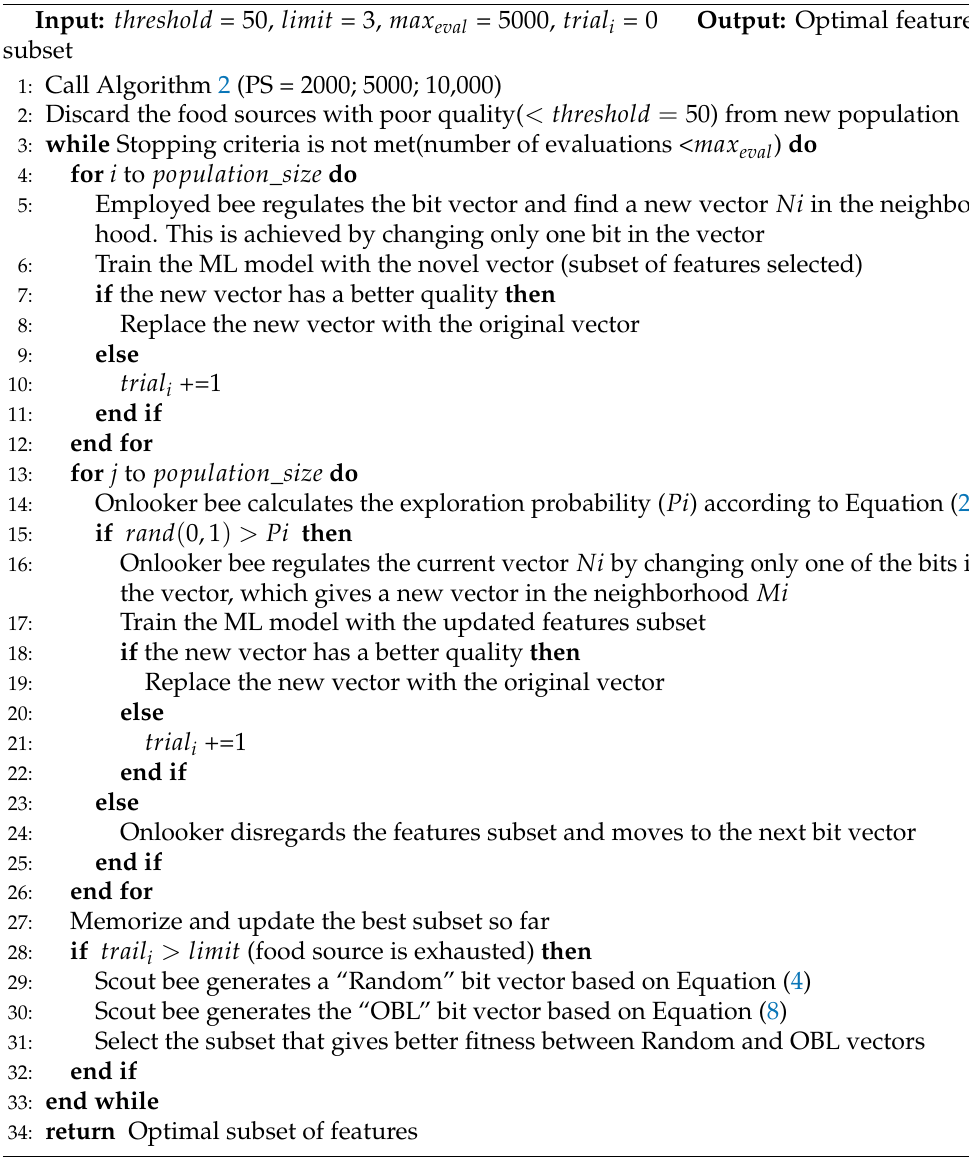
Algorithm 3 Proposed